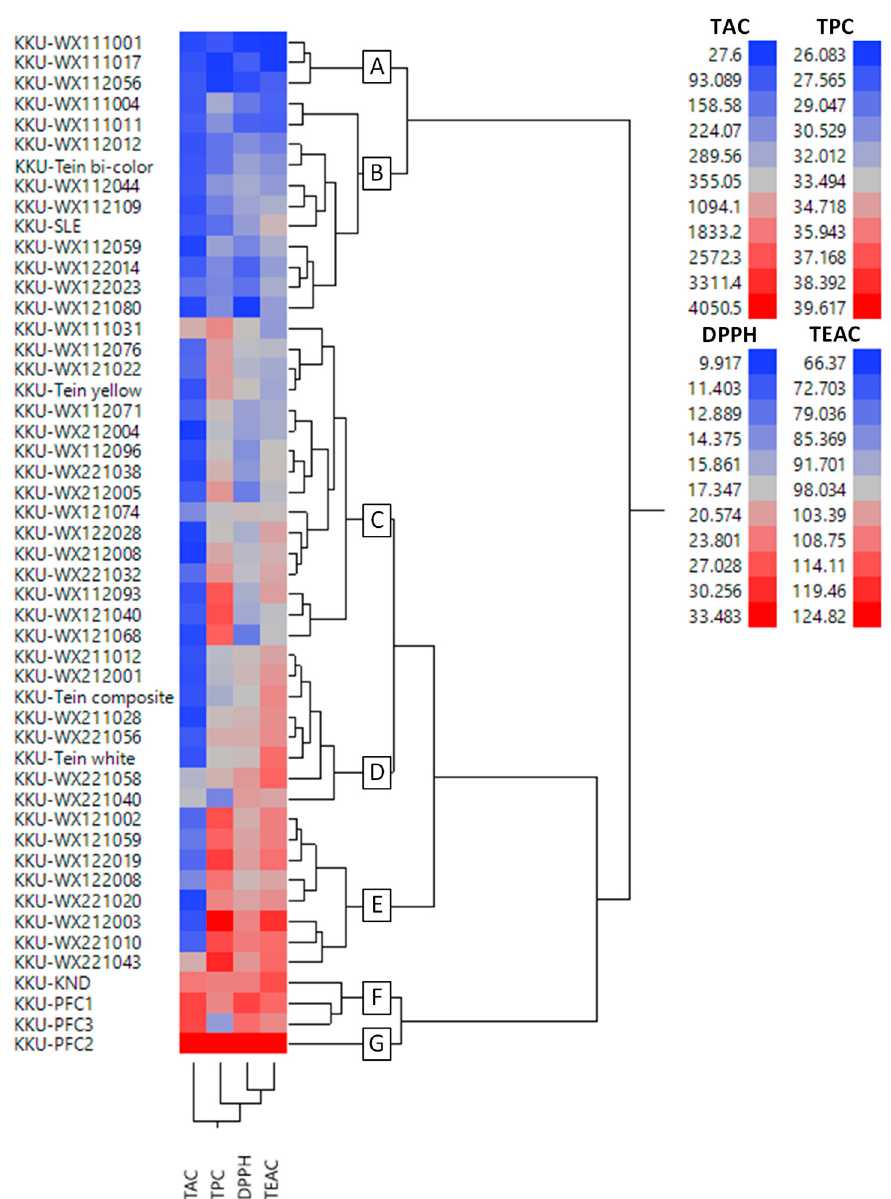
Figure 2. Seven clusters of the relationships based on the total anthocyanin content (TAC), total phenolic content (TPC) and antioxidant capacity determined by DPPH and TEAC assays in the tassel among 50 waxy corn genotypes. A two-way Ward’s clustering analysis was used.